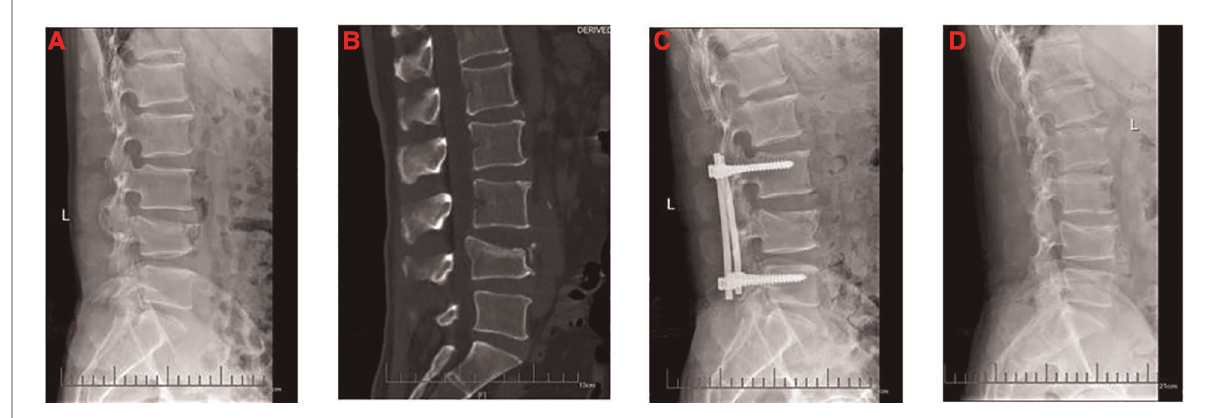
FIGURE 1 The preoperative and postoperative radiographs of four-pedicle screw fi xation group. ( A ) Preoperative lateral x-ray. ( B ) Preoperative lateral computed tomography. ( C ) Lateral x-ray 1 month after surgery. ( D ) Lateral x-ray at fi nal follow-up.